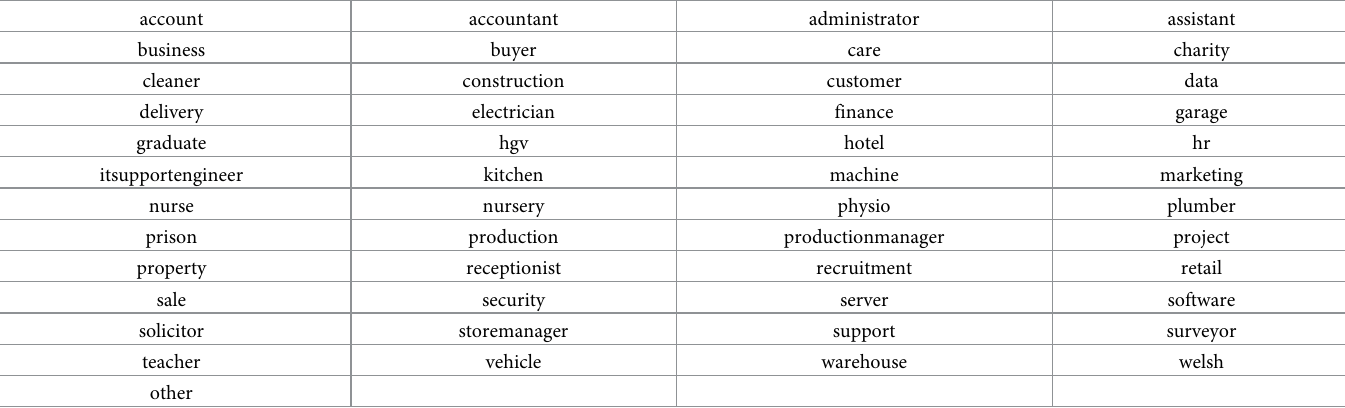
Table 1. Job category labels. These labels are summaries of the most common job title in each category. The category ‘other’ contains jobs which could not be classified into one of the other